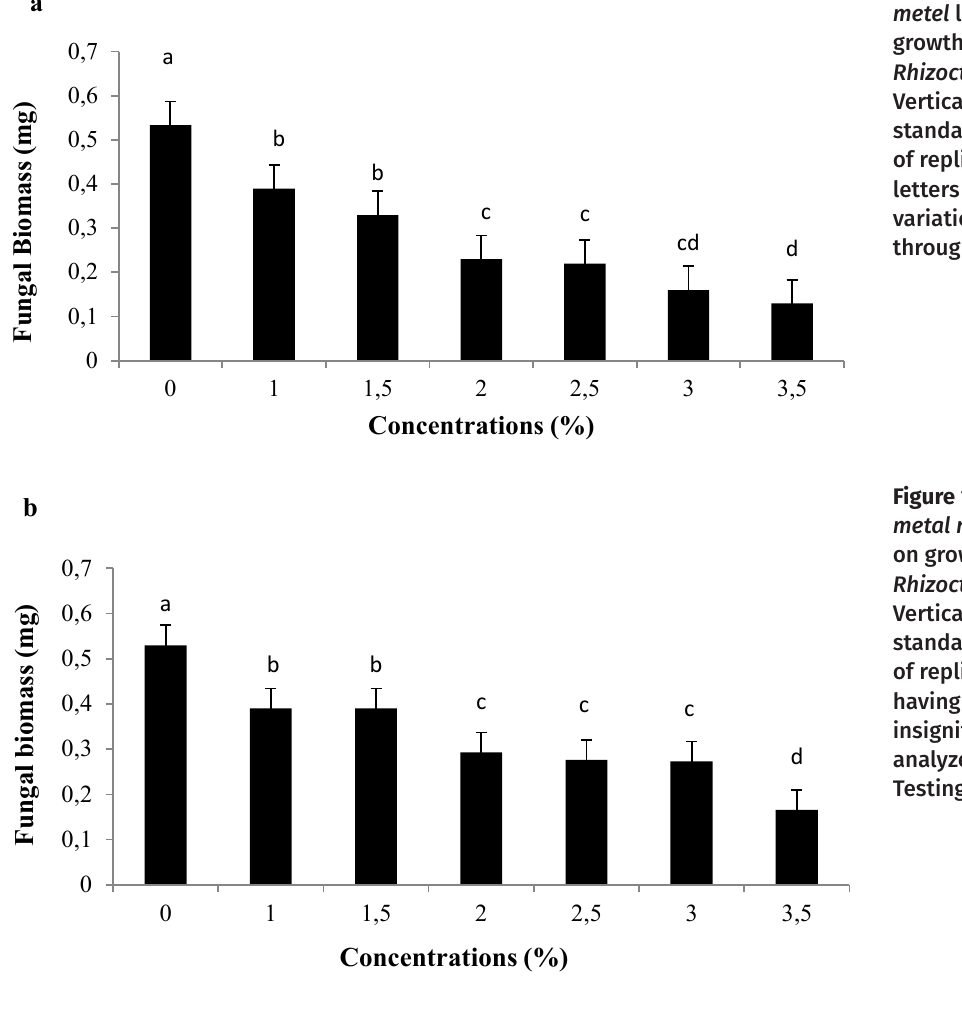
Figure 1a. Effect of Datura metel leaf extract on growth of test fungus Rhizoctonia solani . Vertical bars indicated standard error of means of replicates. Value having letters showed significant variations analyzed through LSD Testing.